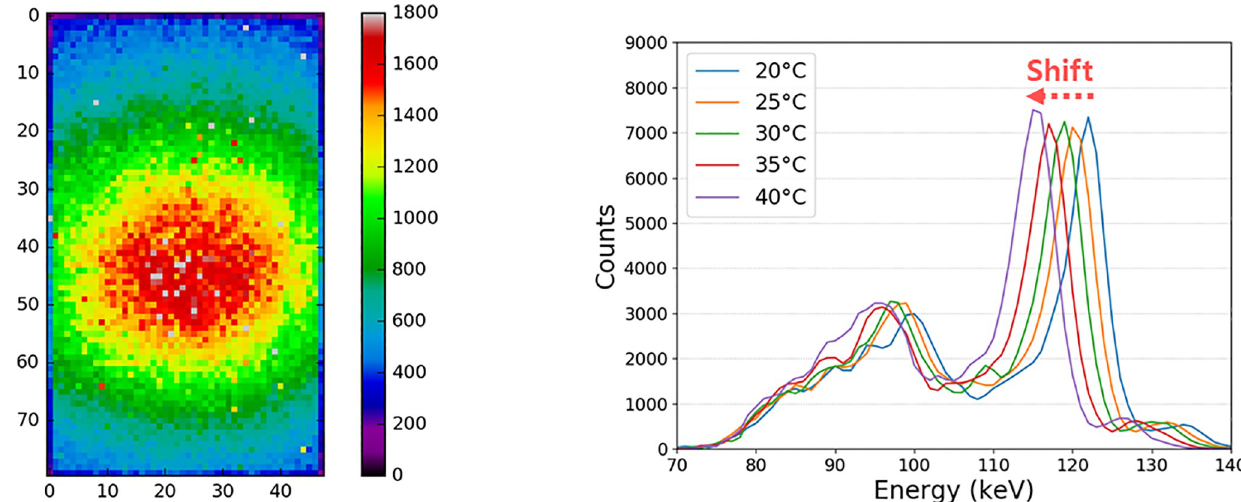
Fig 13. (a) Hybrid chip image using Co-57 (3.7 MBq) source. (b) Energy peak according to temperature. As the temperature rises, it shifts to the